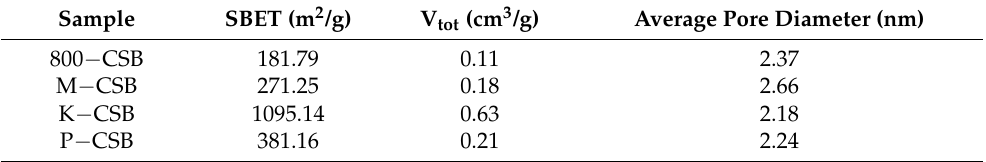
Table 2. Texture characteristics of the samples.